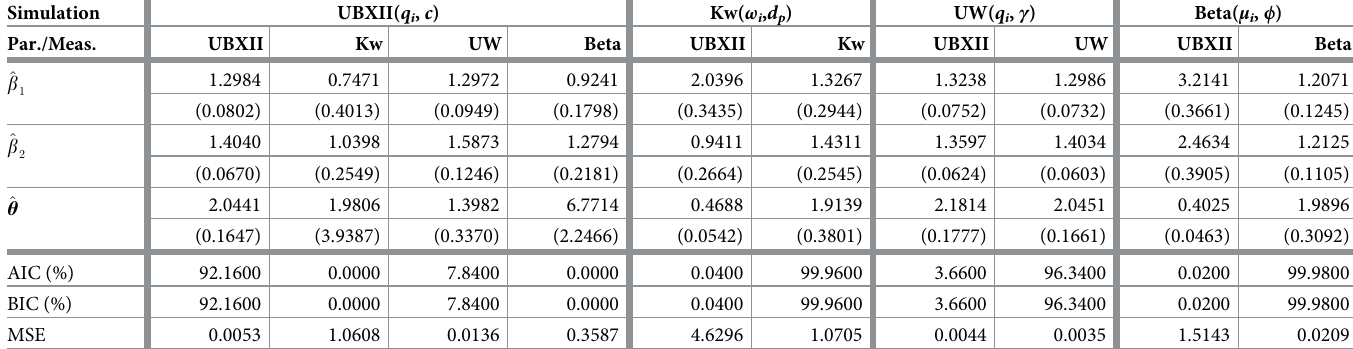
Table 3. Results of Monte Carlo simulations for Scenario 1 ( β 1 = 1.3, β 1 = 1.4, and c = 2.0), with n = 100 and R = 5000 replications and MSE mean, AIC and BIC fre- quencies (%) of correct model selection.